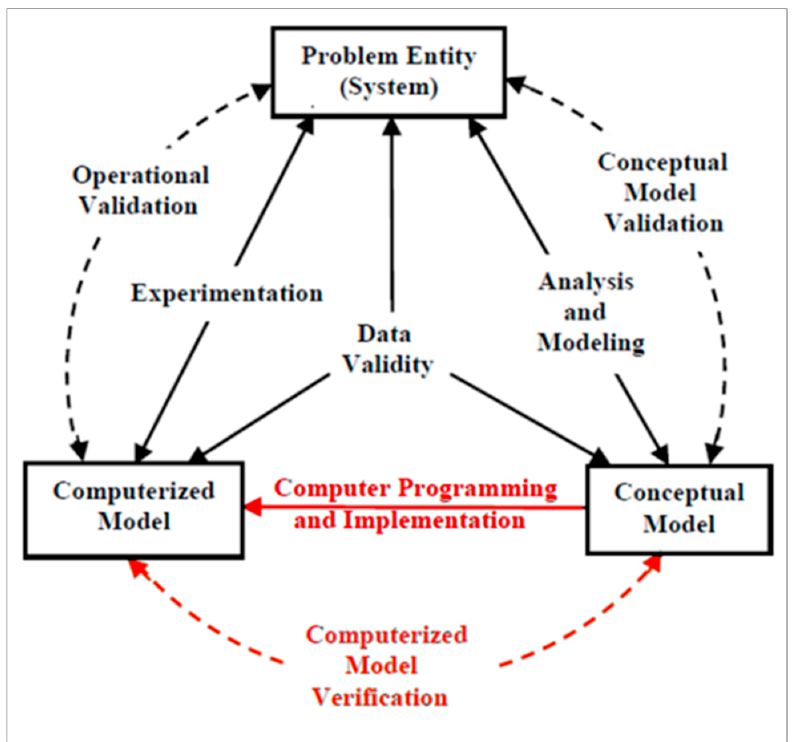
Figure 1. Simplified modeling process for a simulation project [10], showing in red the aspects that will be affected by the proposed methodology. The conceptual model-tool mapping simplifies the verification process and encoding.